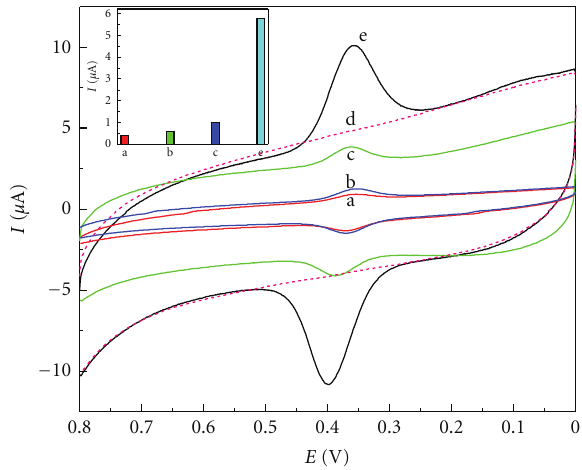
Figure 3: Typical CVs of (a) bare GC, (b) Pt/GC, (c) GR/GC, and (e) Pt/GR/GC electrode in 0.1 M pH 5.0 phosphate bu ff er solution containing 5 µ M rutin. (d) CV of Pt/GR/GC electrode in 0.1 M pH 5.0 phosphate bu ff er solution without Rutin. Inset: comparison of anodic peak currents obtained in 5 µ M rutin solution at di ff erent